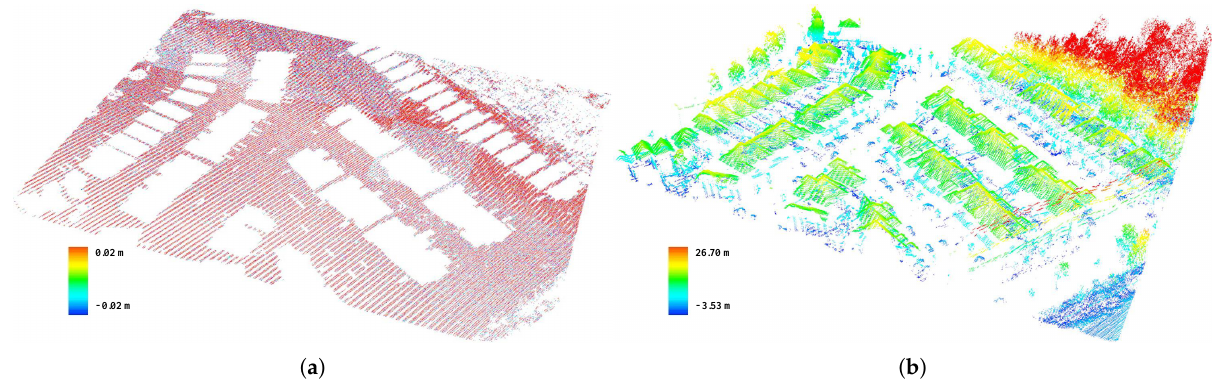
Figure 8. Ground filtering of LiDAR data. ( a ) Ground points. ( b ) Non-ground points.